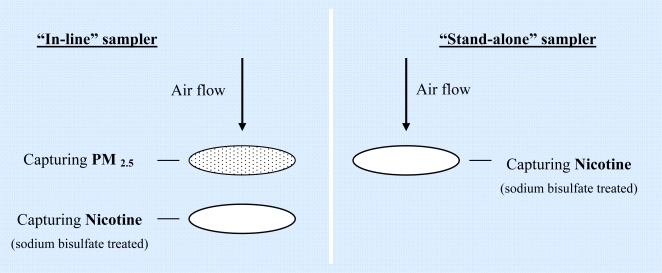
Sampling designs of “stand-alone” sampler and “inline” sampler.